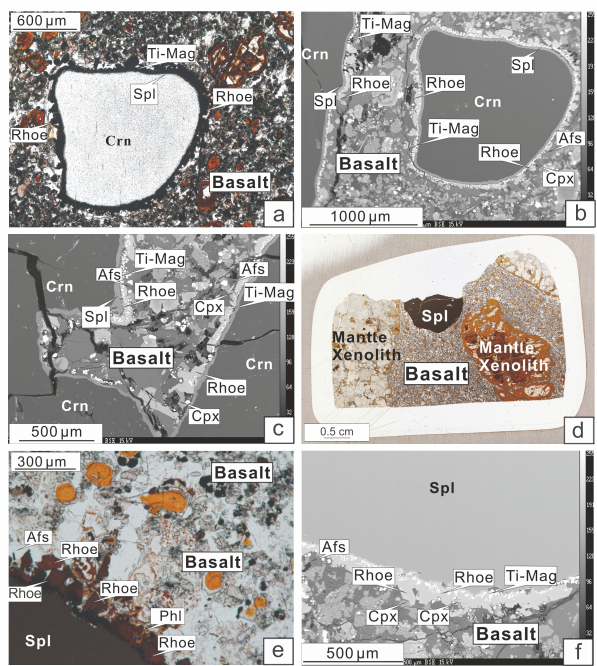
Figure 3. Microphotographs and hand-specimen photo of rhönite- bearing samples EGS03 (a–c) from Ergushan and SS17 (d–f) from Suishan. (a, b) Intergrowth texture of rhönite with olivine and phl- ogopite. (c) Fine-grained rhönite coexisting with Ti-bearing mag- netite, olivine and alkali feldspar, both along phlogopite cleavage planes or as rims around phlogopite. (d) Xenolith in basalt. (e, f) Lo- cally altered xenolith with rhönite forming intergrowth textures with spinel, clinopyroxene, olivine, alkali feldspar and former basaltic melt. (a, b, e, f) PPL. (c) BSE. (d) Macrophotograph. ple CL01 from Fangshan hill contains 9.47 wt %–11.69 wt % MgO and 22.29 wt %–24.47 wt % FeO, and in sample